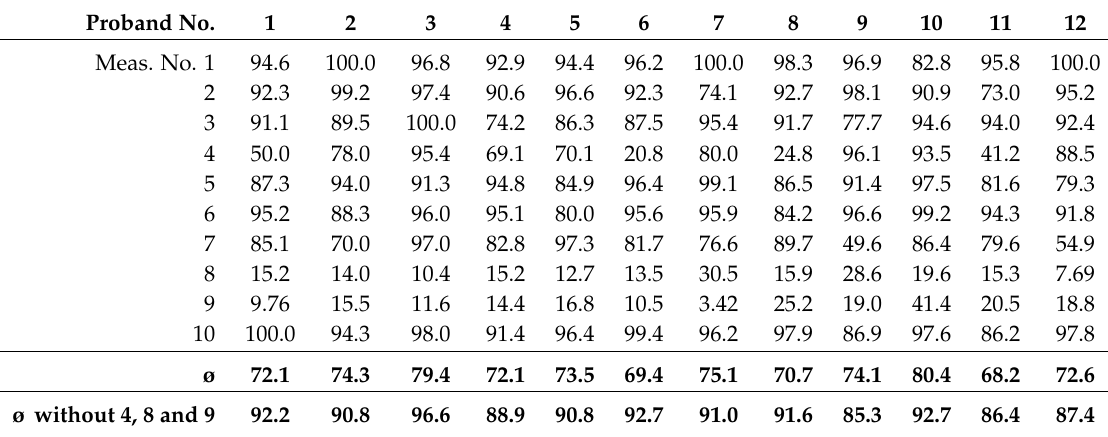
Table 5. F 1 -score (in %) of the classified PCG by using the HT. Proband No.